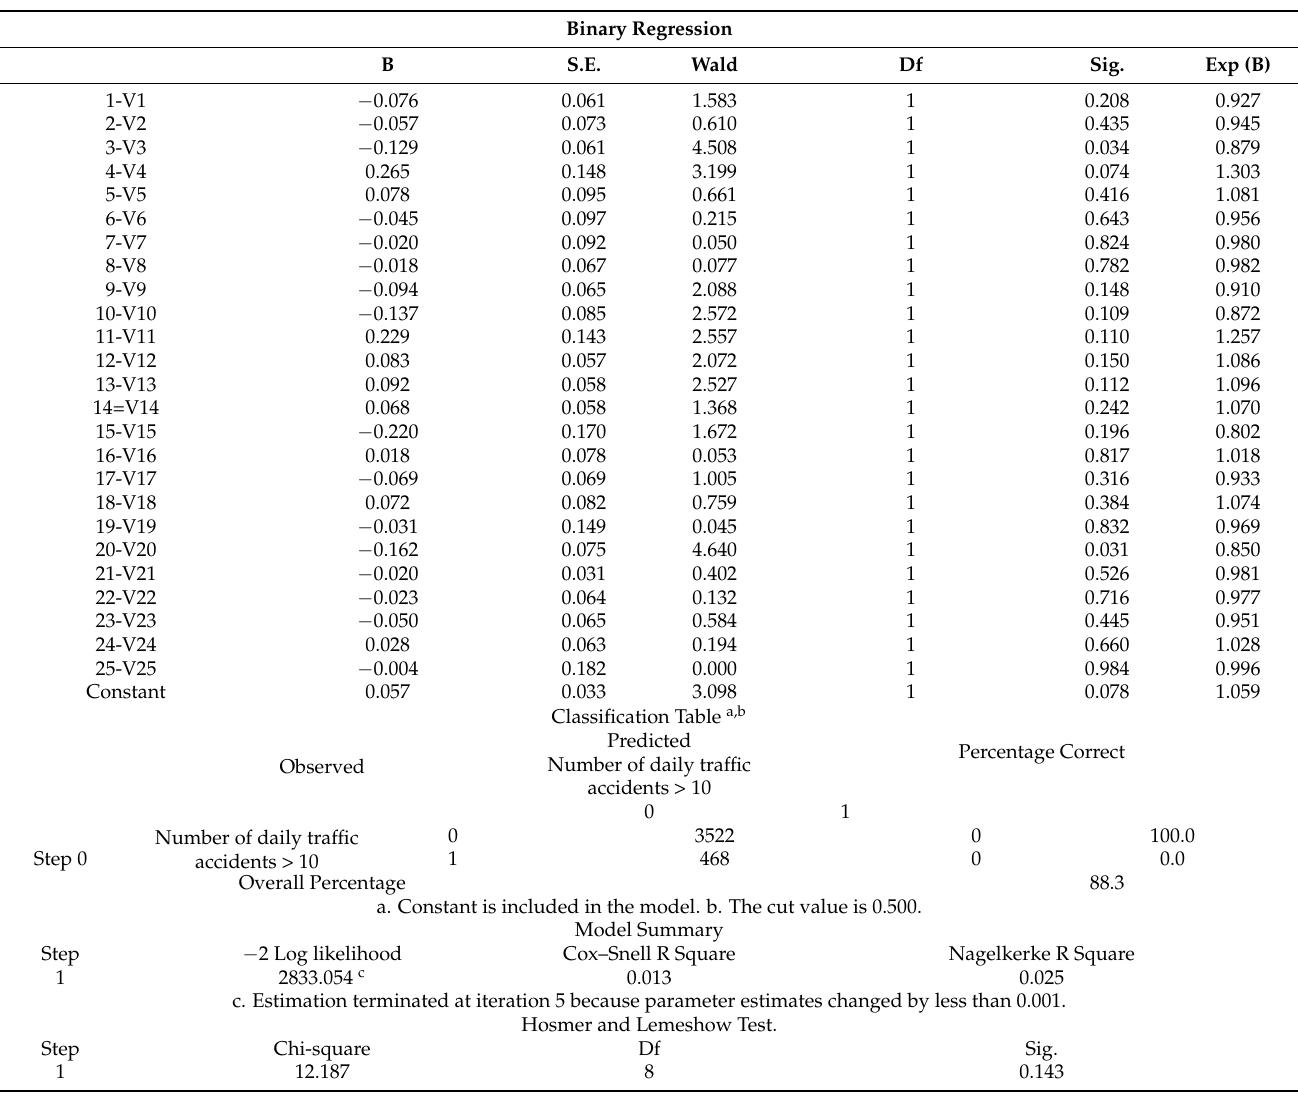
Table 3. Results of applied binary regression—all 27